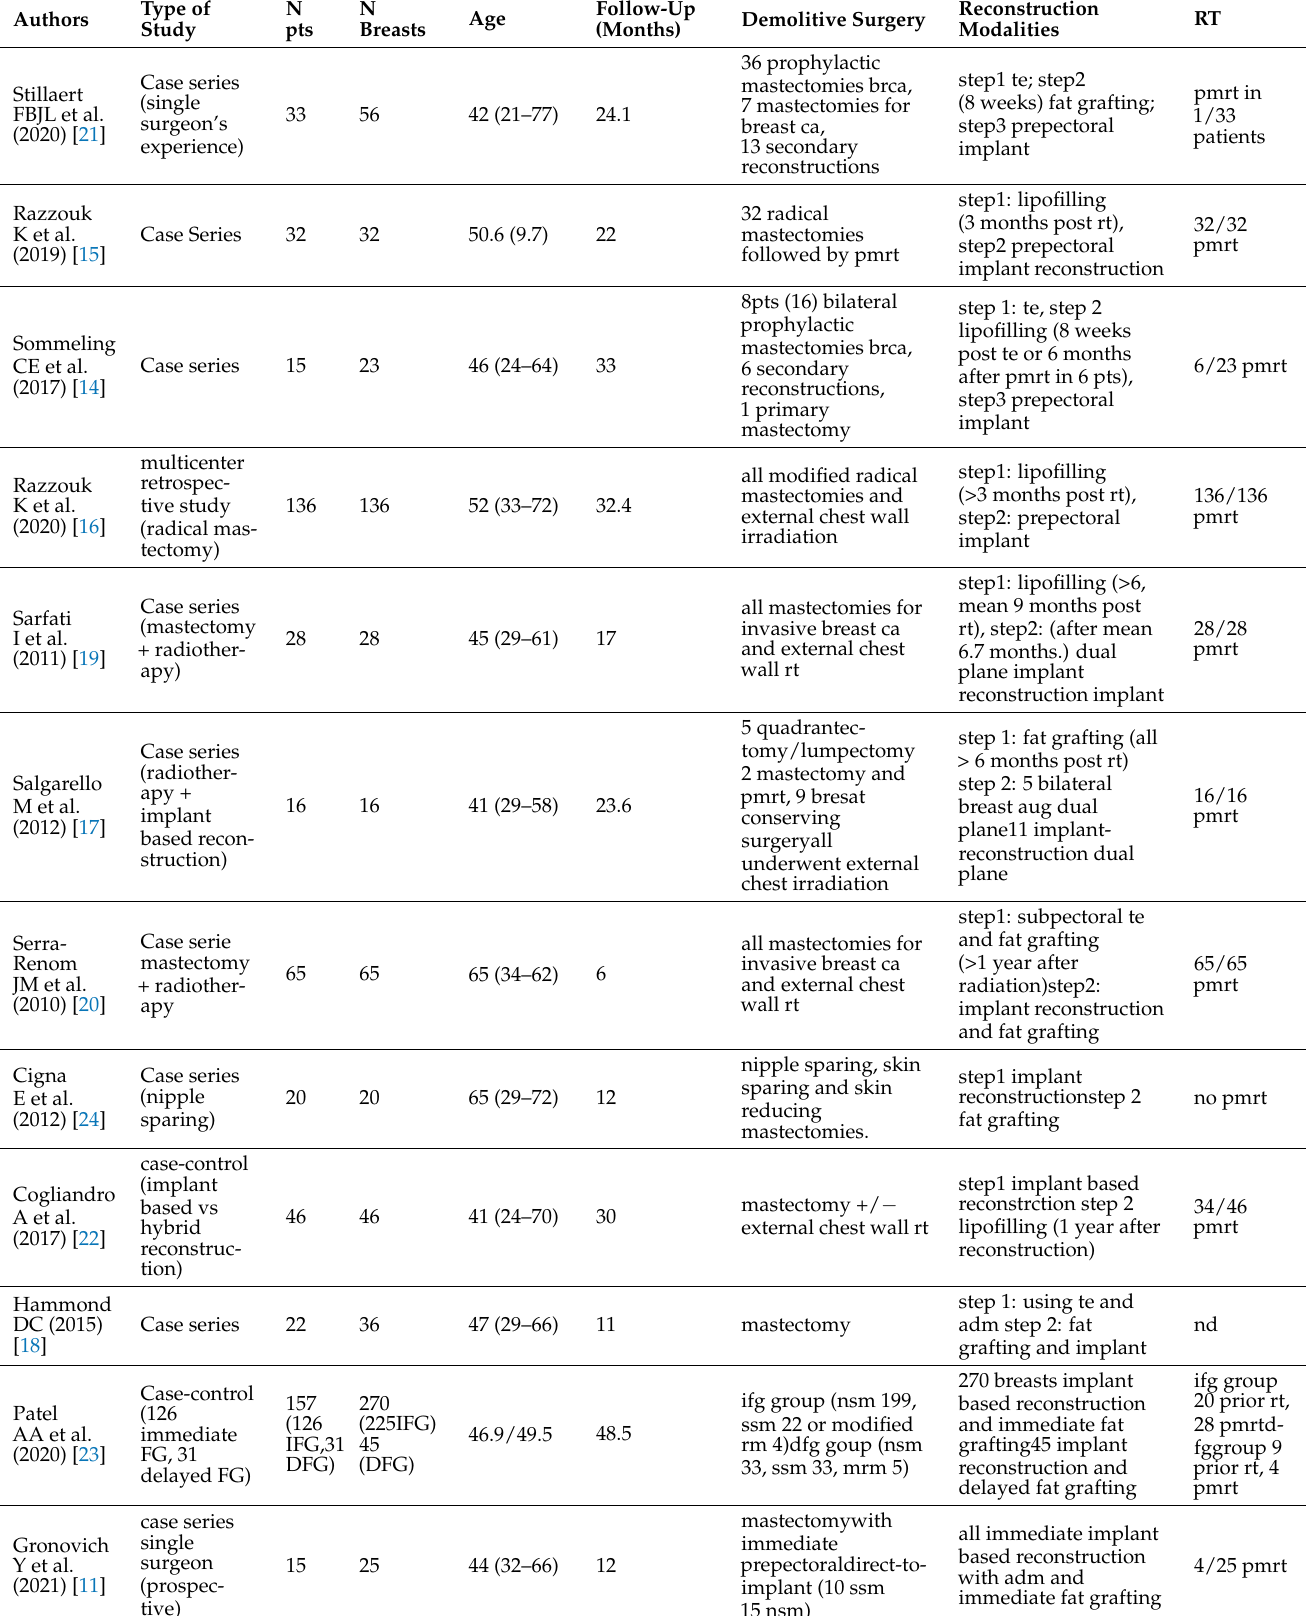
Table 1. Demographic